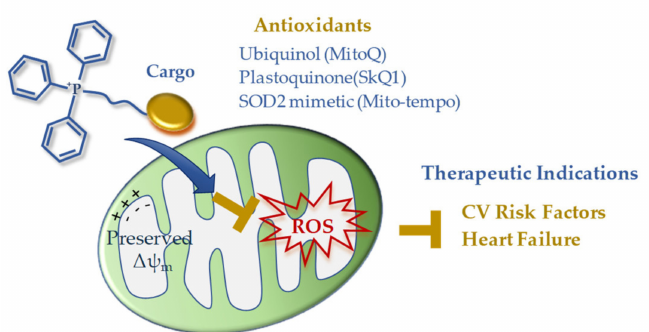
Figure 1. Mitochondria-targeted delivery of antioxidants based on triphenilphosphonium lipophilic